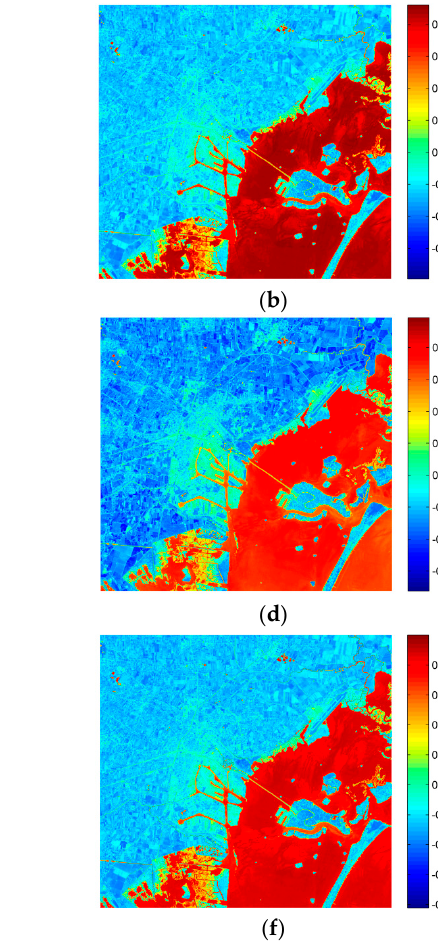
Figure 2. ( a ) Ten-metre NDWI 10m produced by the original green and NIR bands; ( b ) 20-m MNDWI 20m (M, Modified) produced by the upscaled green band and the original SWIR band; ( c ) 10-m MNDWI PCA produced by the original green band and the PCA-sharpened SWIR band; ( d ) 10-m MNDWI IHS produced by the original green band and the his-sharpened SWIR band; ( e ) 10-m MNDWI HPF produced by the original green band and the High Pass Filter (HPF)-sharpened SWIR band; ( f ) 10-m MNDWI ATWT produced by the original green band and the À Trous Wavelet Transform (ATWT)-sharpened SWIR band. The three black square frames shown in ( a ) indicate the locations of Subareas A, B and C, respectively.